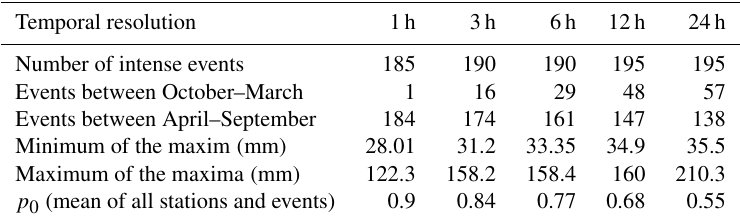
Table 2. Statistics of the selected intense precipitation events based on the primary network.